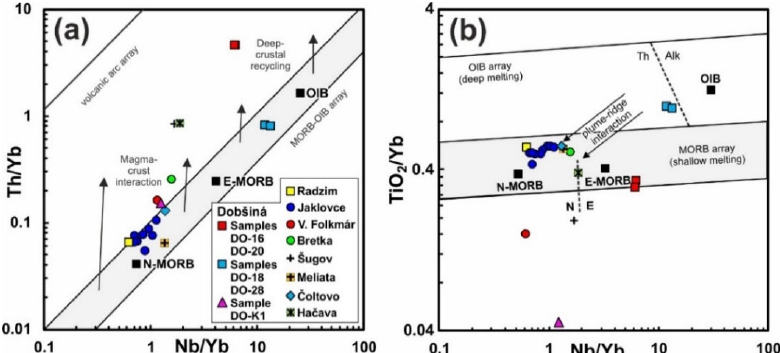
Figure 12. Meliatic metabasalts in the Th/Yb versus Nb/Yb and TiO 2 /Yb versus Nb/Yb Proxy discrimination diagrams of [109]. ( a ) Most N ‐ MORBs remain in the mantle array, thus suggesting subduction ‐ unrelated upper mantle sources. The BRT, DO ‐ K, and VFK N ‐ MORBs may exhibit weak interaction with the crustal rocks from Jurassic subduction. Samples DO ‐ 18 and 28 are close to the OIB field. The DO ‐ 16, DO ‐ 20, SUG, and HAC calc ‐ alkaline basalts may indicate deep ‐ crustal recycling in a volcanic arc. ( b ) N ‐ MORBs may suggest plume ‐ ridge interaction in the initial stage of a marginal oceanic crust evolution (samples DO ‐ 18 and 28). Samples with decreased TiO 2 are outside the OIB and MORB fields.